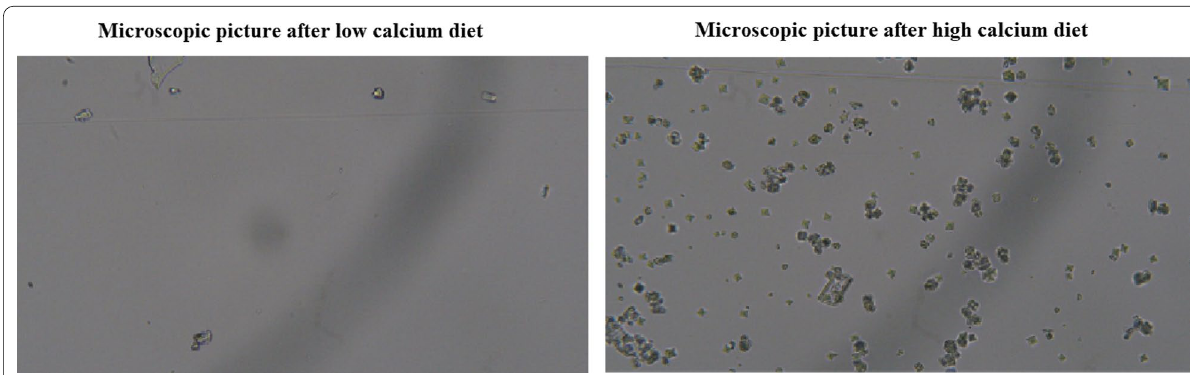
Fig. 1 The number and size of crystals induced by supersaturation during crystal aggregation studies. EMU 2 h